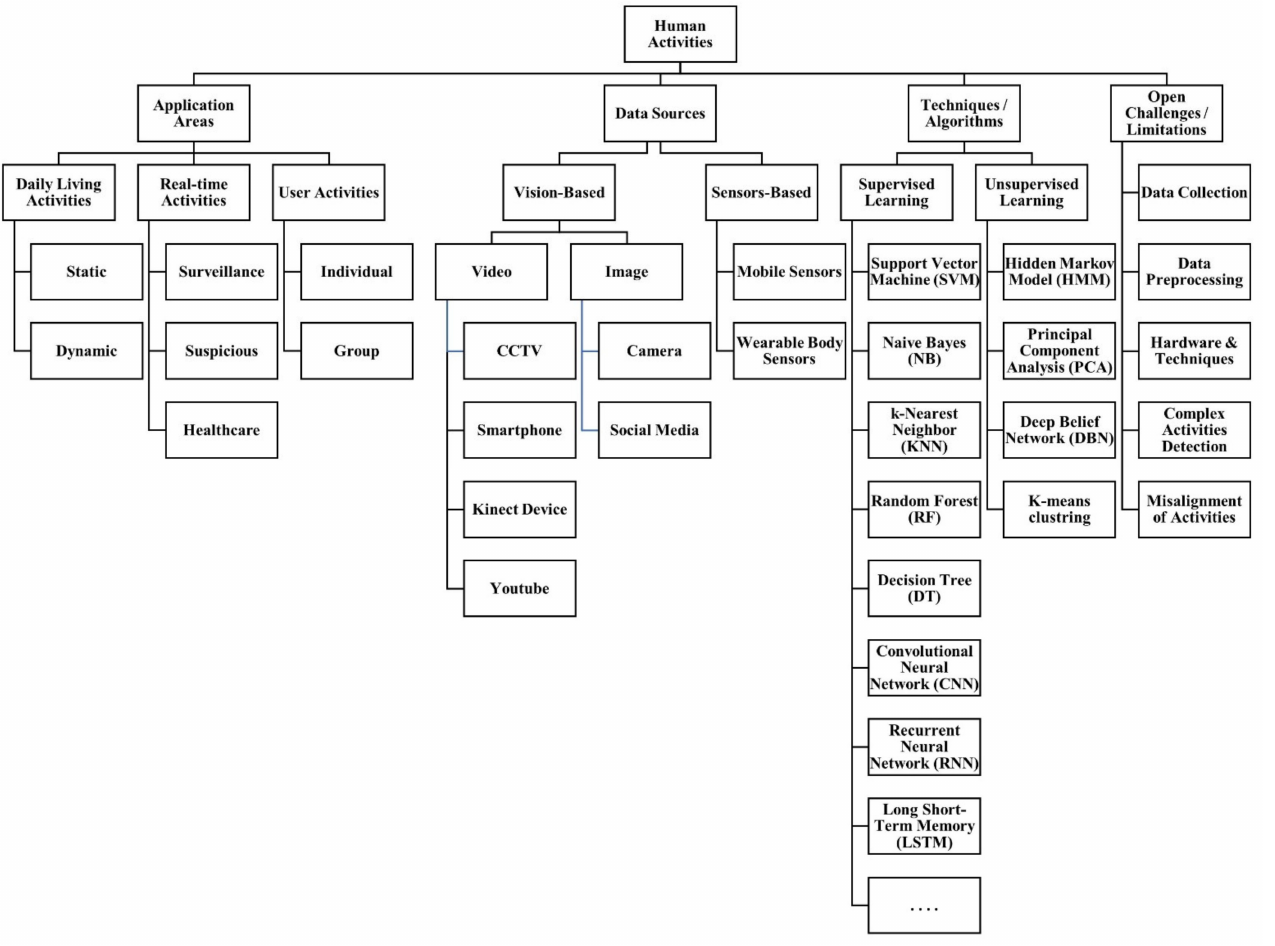
Figure 2. Taxonomy of